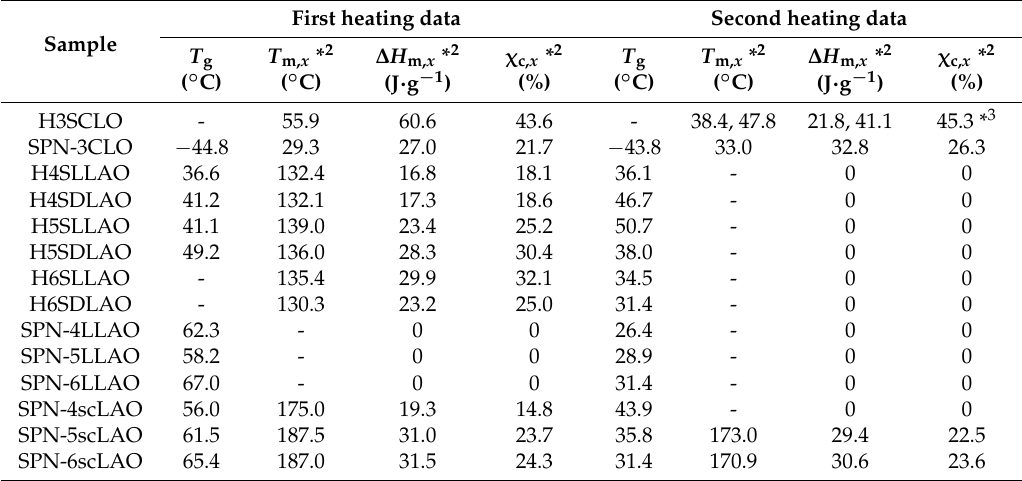
Table 2. DSC data for H3SCLO, SPN-3CLO, H m SLLAOs, H m SDLAOs, SPN- m LLAOs and SPN- m scLAOs ( m = 4, 5 and 6) * 1 .